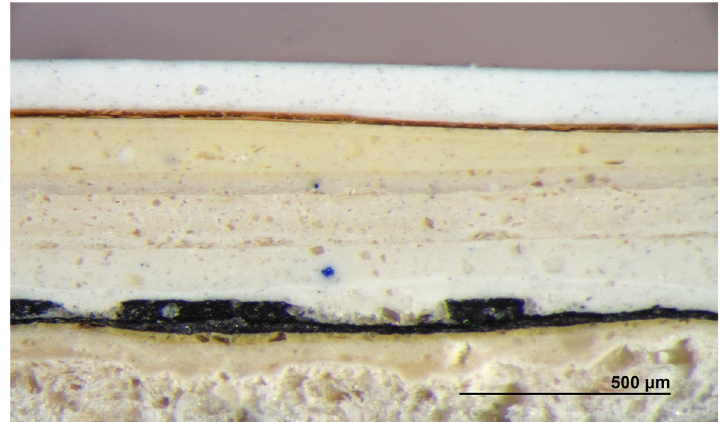
Fig. 13 Black paint layer. The cross section shows incomplete layers, indicating the previous scaling of the paint before applying white covering finishes. The beige or off-white primer is visible under the black finishes. (Source: the